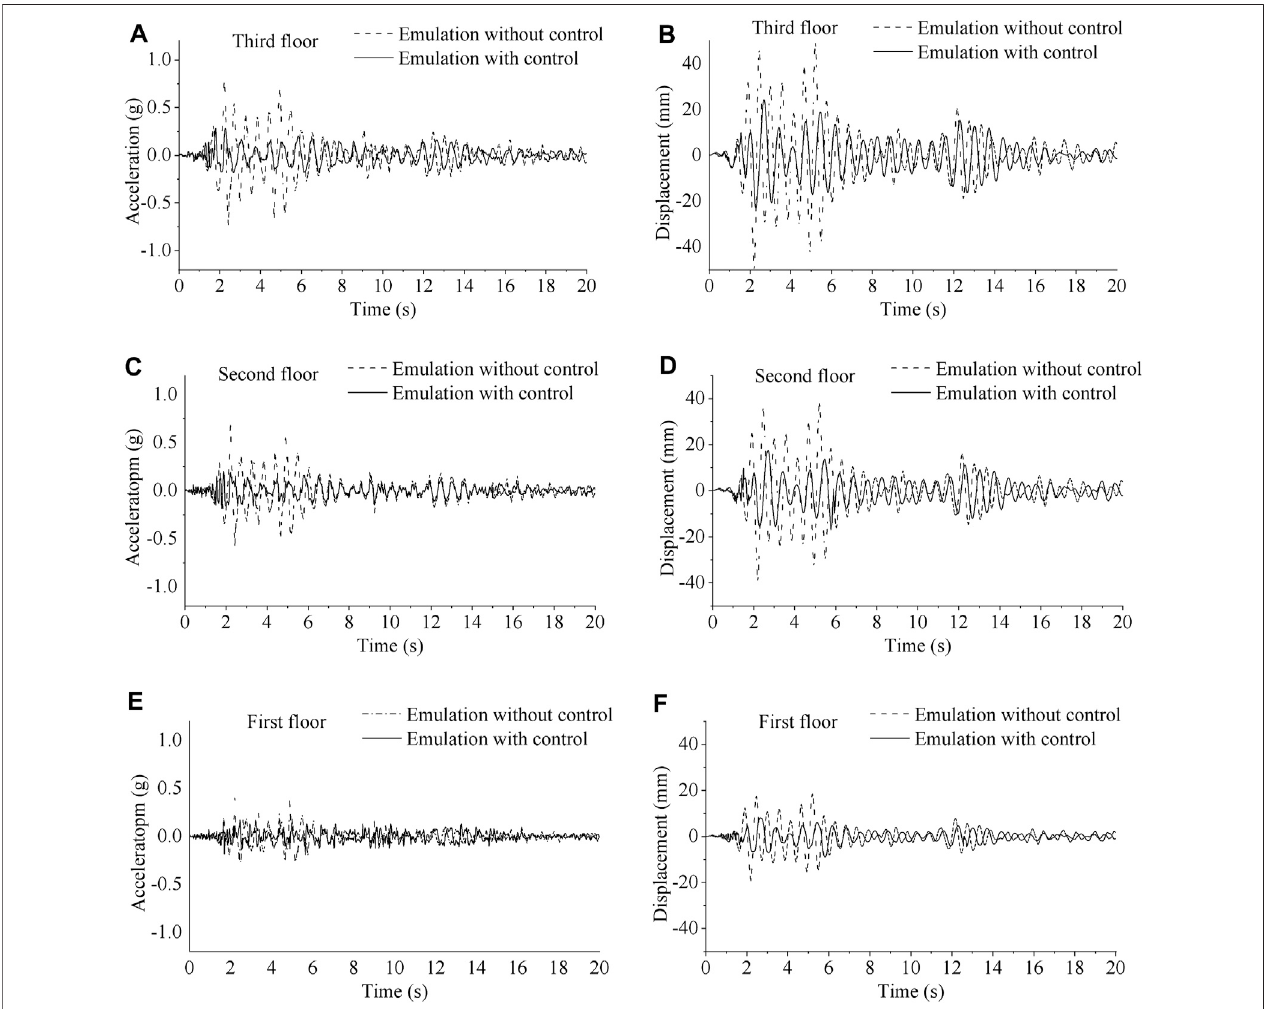
FIGURE 6 | Time history curve of displacement response and acceleration response on model structure in emulation: (A) acceleration response on the third fl oor, (B) displacement response on the third fl oor, (C) acceleration response on the second fl oor, (D) displacement response on the second fl oor, (E) acceleration response on the fi rst fl oor, and (F) displacement response on the fi rst fl oor.